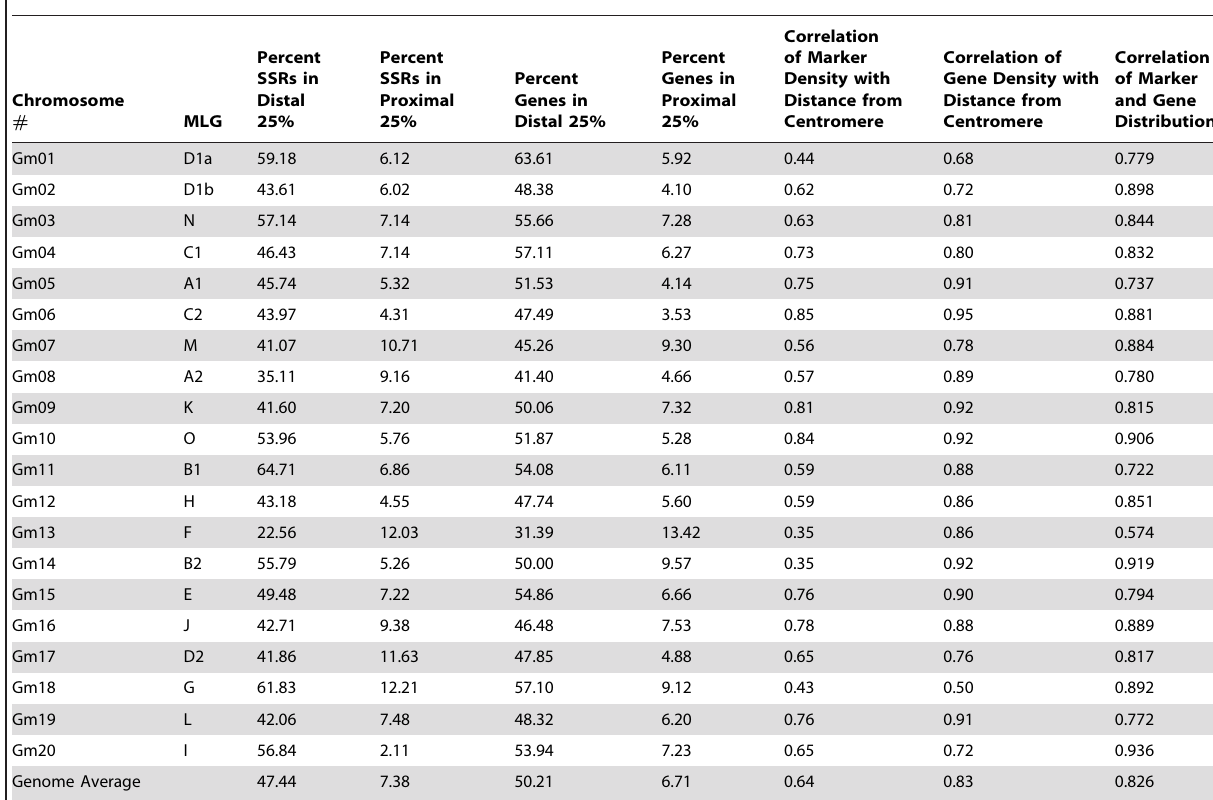
Table 1. Distribution of genes and SSR markers on soybean chromosomes.